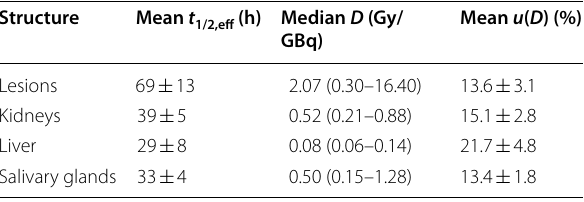
( standard deviation 1,2,eff ± range) and uncertainty u ( D ) +